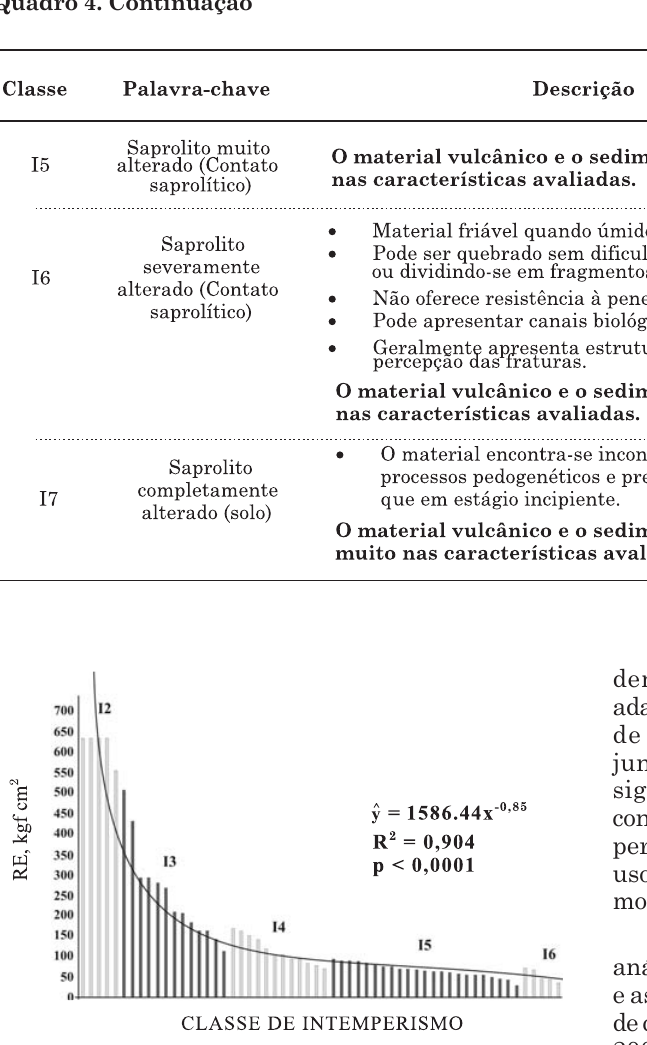
Figura 2. Relação entre as classes de intemperismo e a resistência à escavação (RE) pelo método do penetrômetro de impacto para as camadas saprolíticas de Neossolos Litólicos e Neossolos Regolíticos derivados de arenito da Formação